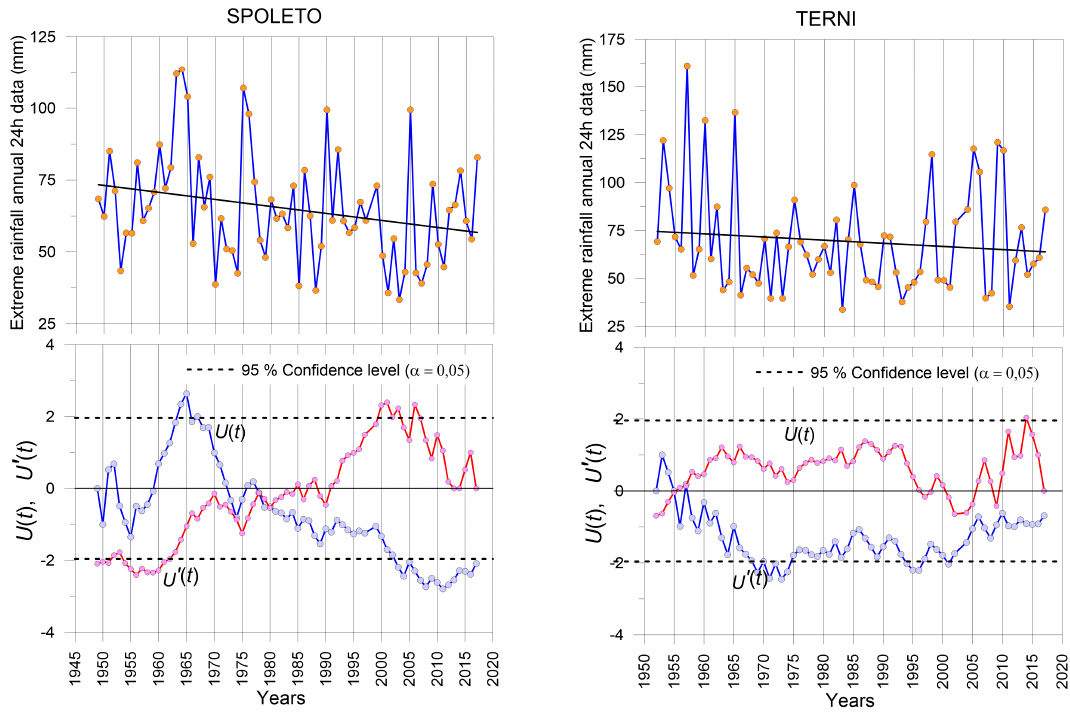
Figure 2. Results obtained from the sequential Mann–Kendall test in the Spoleto and Terni stations.